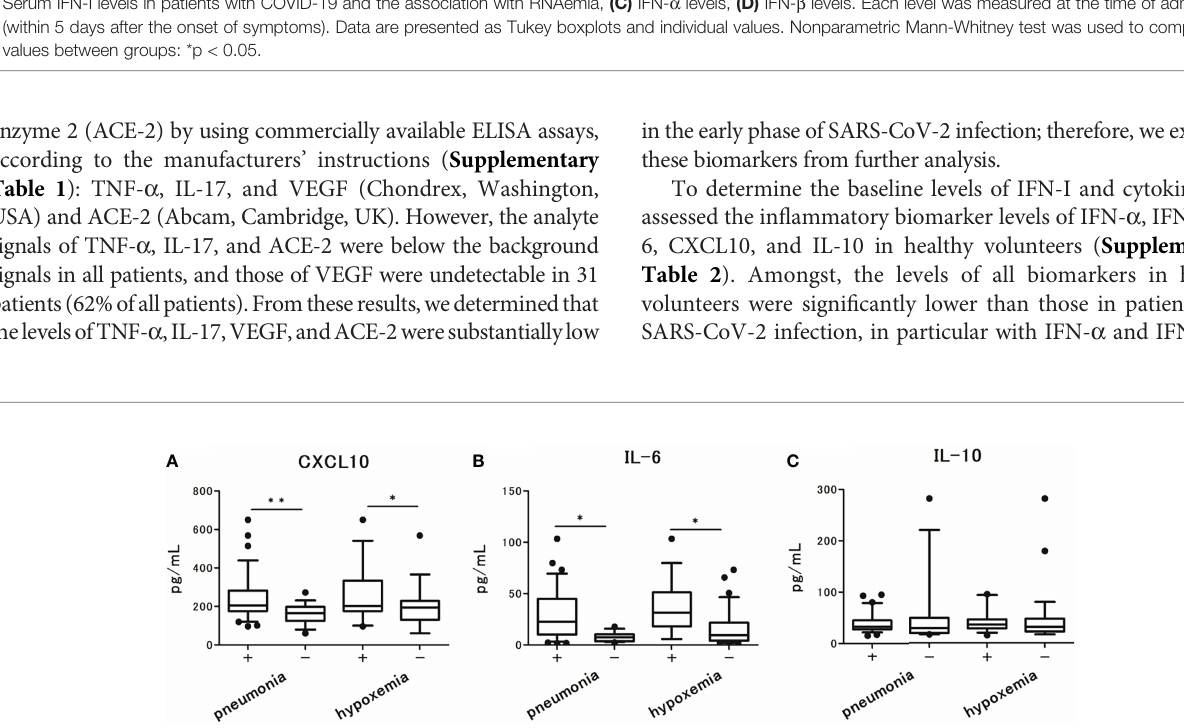
FIGURE 3 | Serum cytokine and chemokine levels in patients with COVID-19 and the associations with pneumonia and hypoxemic respiratory failure: (A) CXCL10 levels, (B) IL-6 levels, and (C) IL-10 levels. Each level was measured at the time of admission (within 5 days after the onset of symptoms), without hypoxemic respiratory failure. One value was excluded from the analyses of IL-6 and IL-10 as an outlier (IL-6 with 476 pg/mL, and IL-10 with 1640 pg/mL). Data are presented as Tukey boxplots and individual values. Nonparametric Mann-Whitney test was used to compare values between groups: *p < 0.05. **p <